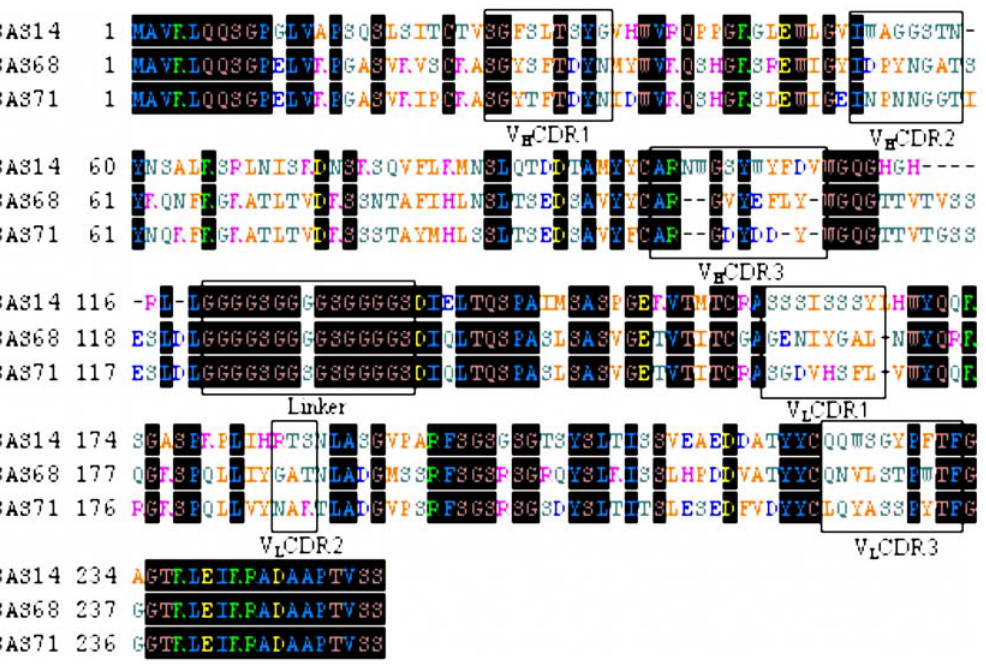
Figure 5. Alignment of the amino acid sequence of selected specific anti-SM 2 scFvs. CDRs and the (Gly 4 Ser) 3 linker are boxed. The regions of CDR1-CDR3 were deduced according to Kabat database.